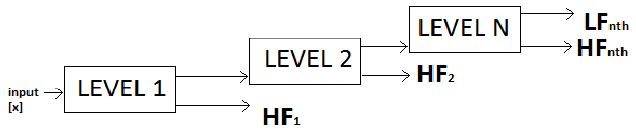
Figure 9. TQWT based N-level decomposition adapted from [6].